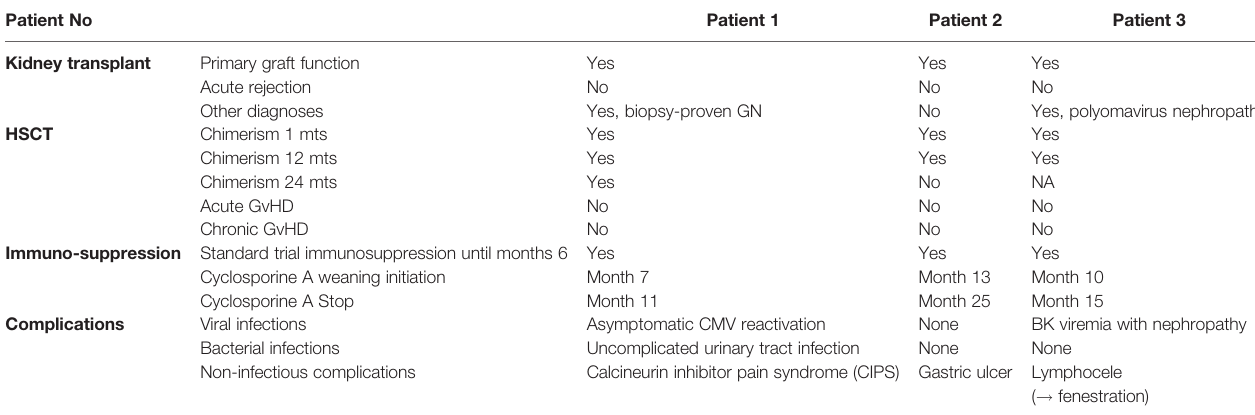
TABLE 2 | Trial outcome overview.